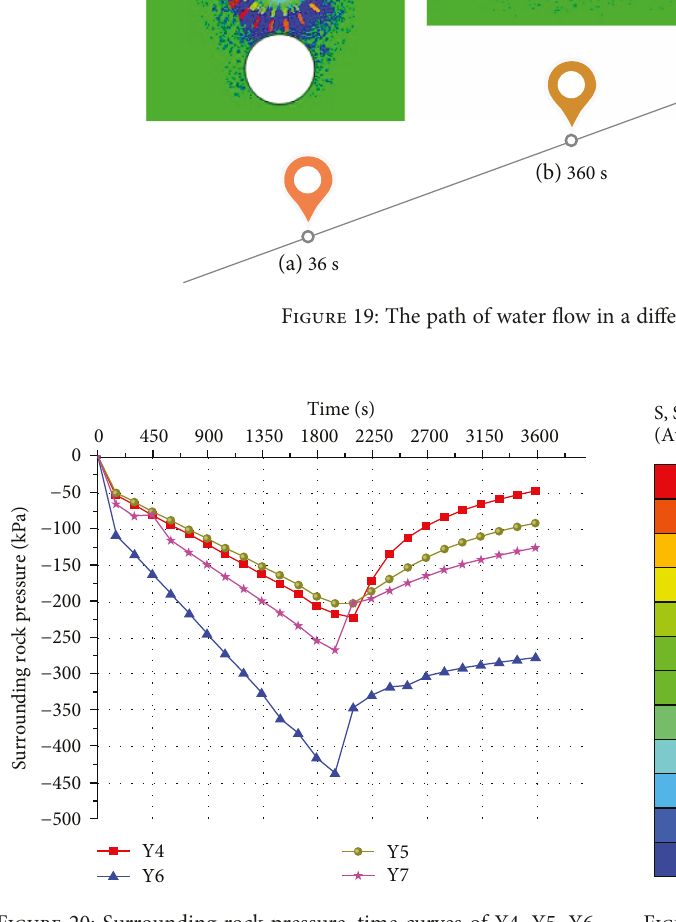
Figure 21: The cloud picture of the maximum principal stress of the lining